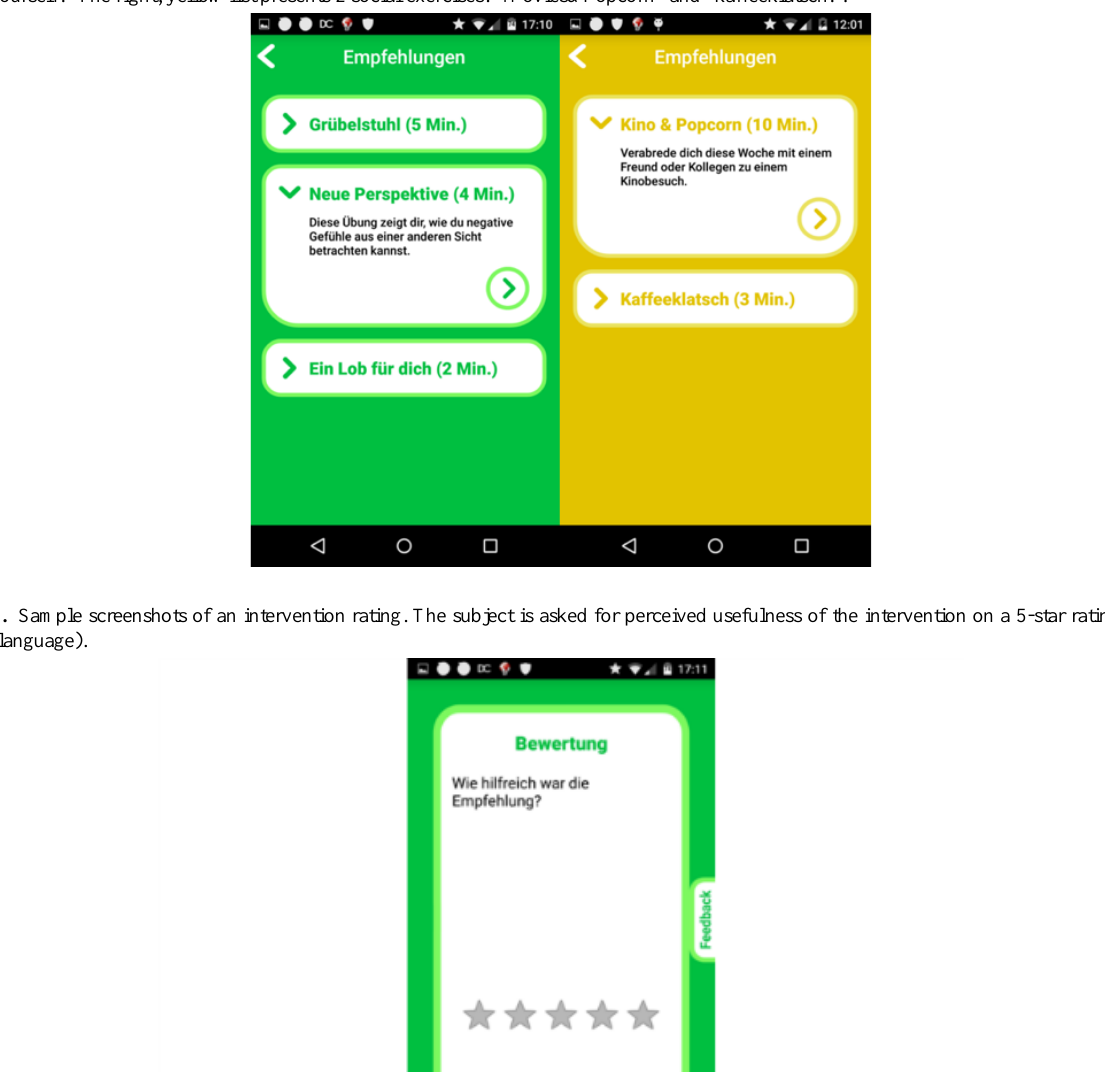
Figure 4. Sample screenshots of lists of interventions of two different baskets. Each item shows the approximate time it takes to carry out the intervention together with a short summary (in German language) Note: The left, green list presents 3 mindfulness exercises: “muse chair,” “new perspective,” and “praise yourself.” The right, yellow list presents 2 social exercises: “Movies&Popcorn” and “kaffeeklatsch.”.